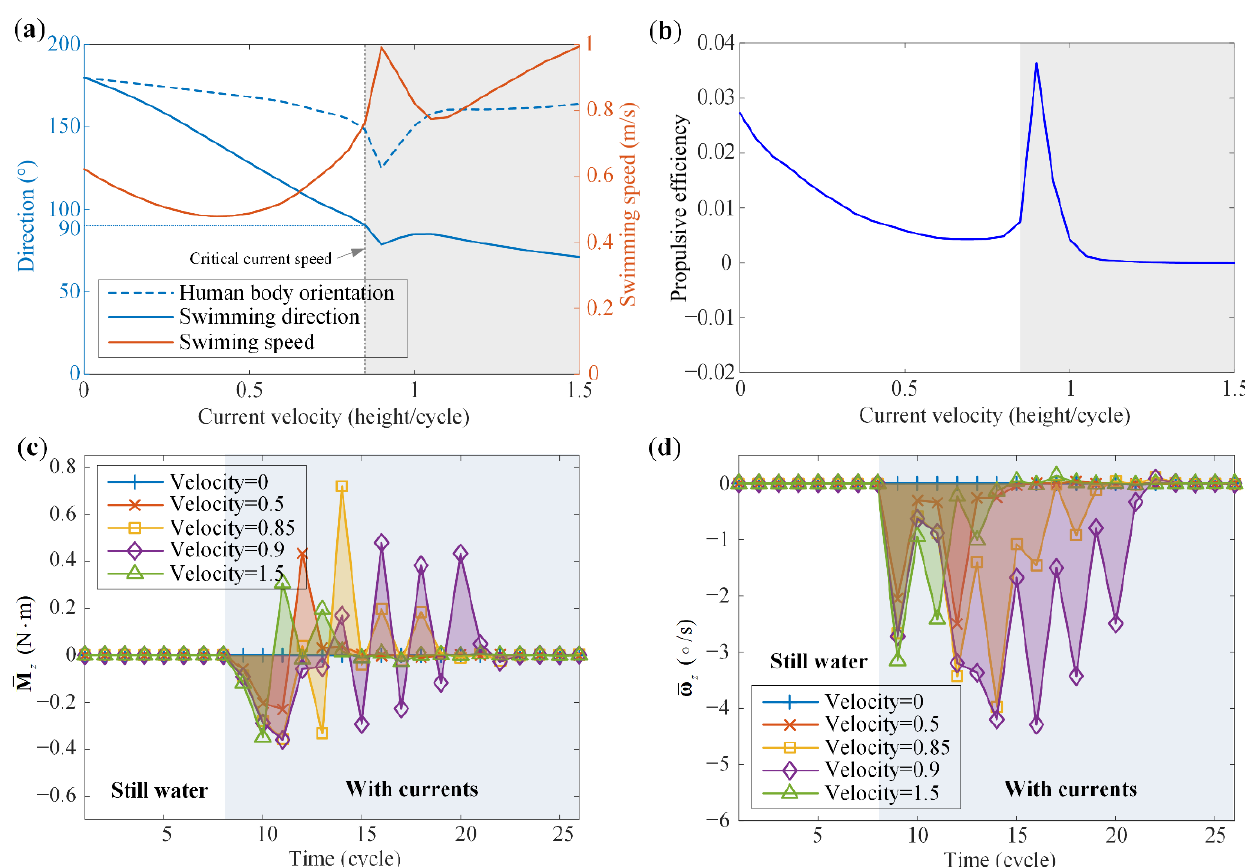
Figure 10. Analyses of the breaststroke swimming performance under the 40 ◦ currents with variable velocity (Case III). ( a ) Evolution of the human body orientation, swimming direction, and swimming speed with respect to the current velocity. ( b ) Evolution of the propulsive efficiency with respect to the current velocity. The shades in ( a , b ) denote the region beyond the critical current speed. ( c ) The average fluid moment per cycle applied to the human body about the global z axis ( M ) at different current velocities. ( d) The average angular velocity of the human body per cycle about the z axis ( ω ) at different current velocities.